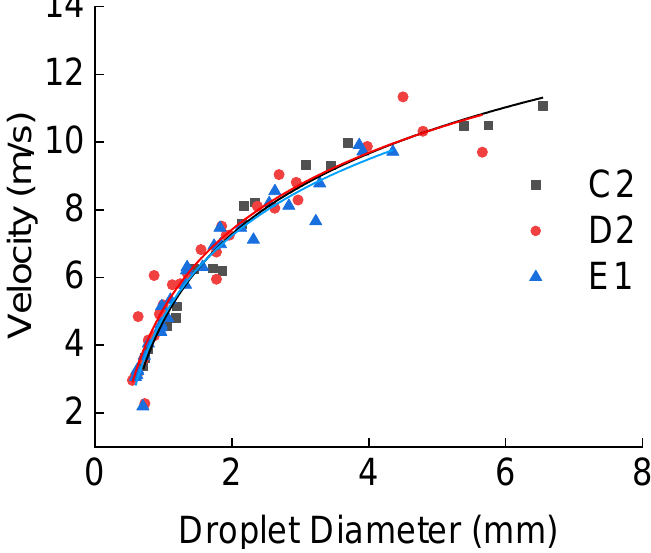
Figure 14. Relationship between average droplet diameter and velocity sprayed from nozzles with different shapes. (C2 refers to the circular nozzle with a diameter of 5 mm; D2 refers to the diamond nozzle with an aspect ratio of 1.32; E1 refers to the elliptic nozzle with an aspect ratio of 1.43).